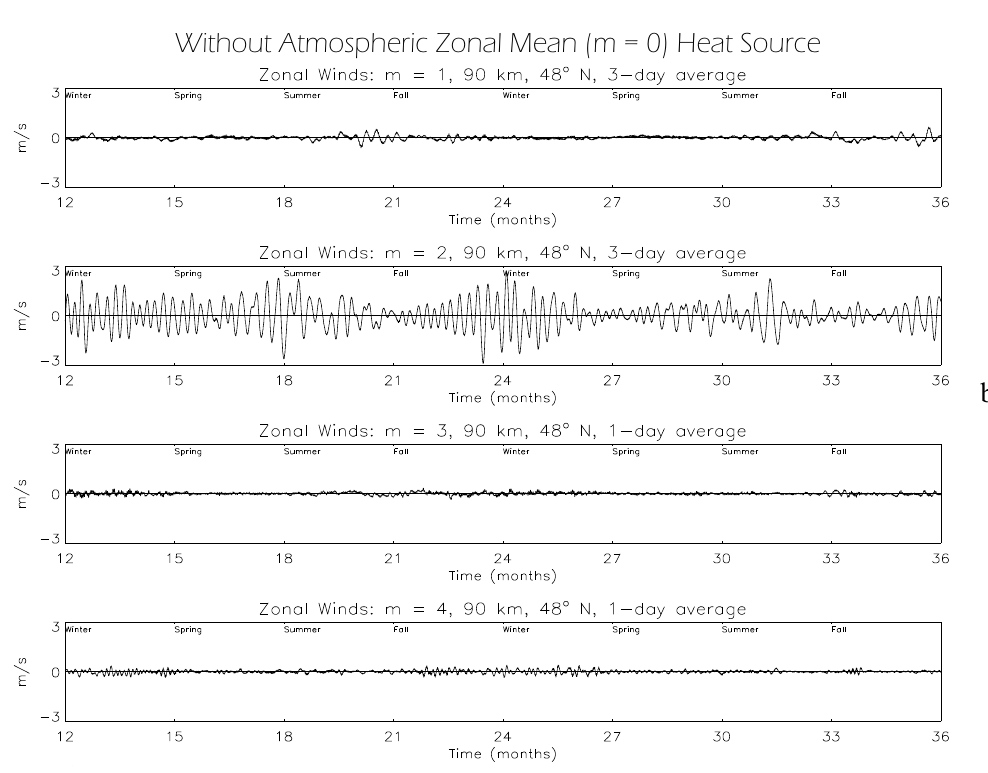
Fig. 5. ( a ) Analogous to Fig. 4a but computed without tropospheric heating. Compared to the standard model with the tropospheric source (Fig. 4a), the short period waves for m=3 and 4 are similar in magnitude, but the amplitudes of the long period waves are significantly smaller in particular for m=1 and 2. This affects significantly the nonmigrating tides as shown in Fig. 6. ( b ) Analogous to Fig. 4a but computed without a heat source for m=0 throughout the atmosphere. Although PWs are generated, e.g. for m=2 in particular, their amplitudes are small by comparison (note the differences in